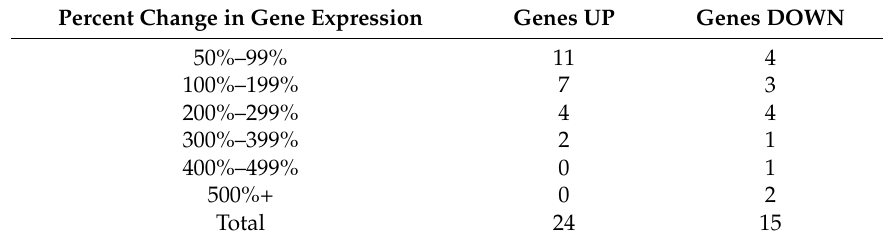
Table 15. Distribution of Genes Affected by GHK and Associated with Glial Cells.